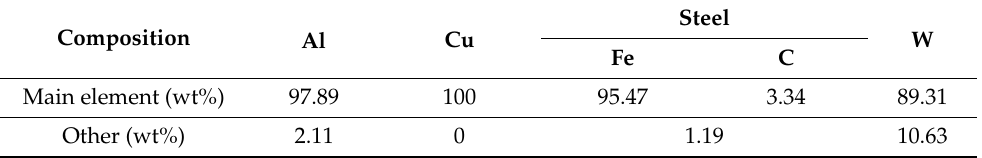
Table 1. Chemical composition of the thermoelements determined from EDAX analysis.